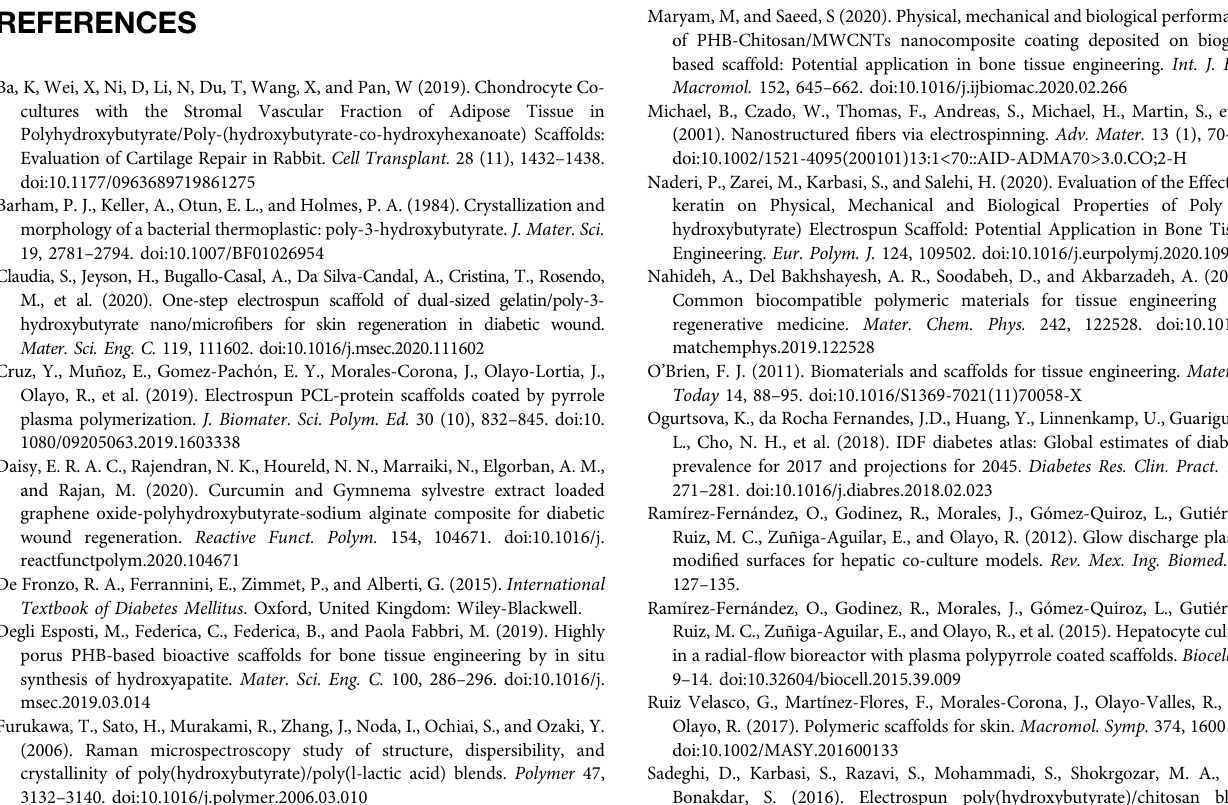
PPyI. Figure 9A corresponds to the PHB scaffold. It is possible to identify both living and dead cells on the image. Some cell colonies are also appreciated. There are more living cells (green) than dead cells